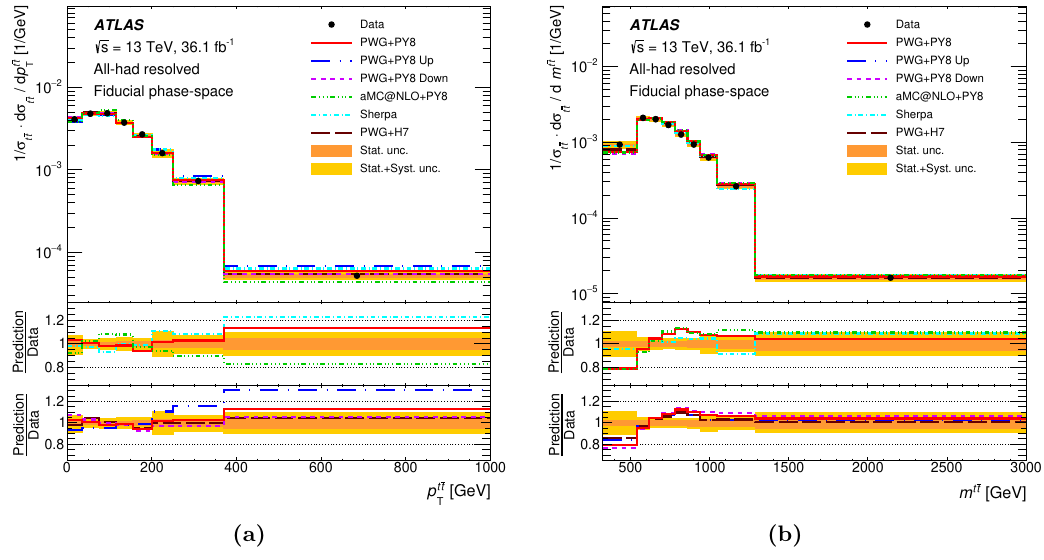
Figure 8 . Particle-level normalised single-differential cross-sections as a function of the (a) trans- verse momentum of the t ¯ t system and of the (b) t ¯ t system mass, compared with different MC predictions. In the top panel, the unfolded data are shown as black points, while lines indicate the predictions from several MC programs. Uncertainties are shown by the shaded bands. Data points are placed at the centre of each bin. The lower two panels show the ratio of the MC predictions to the unfolded